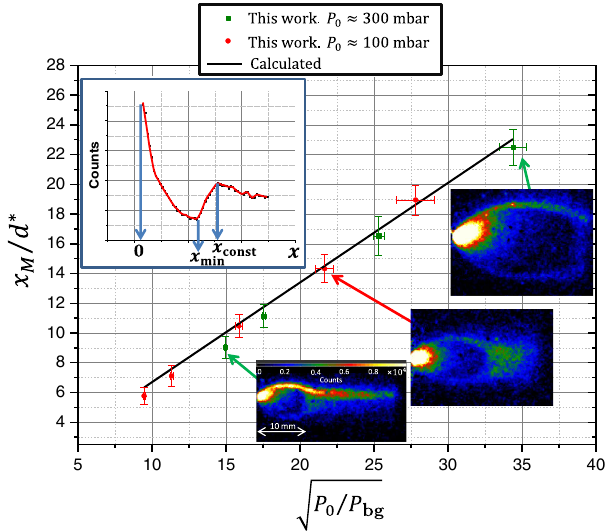
FIG. 7. Distance x M of the Mach disk from the nozzle exit at p ffiffiffiffiffiffiffiffiffiffiffiffiffiffiffi P =P . d (cid:2) ¼ 1 mm. The green and red different values 0 bg symbols correspond to P 0 ≈ 300 mbar and P 0 ≈ 100 mbar as measured with the PLIF spectroscopy, respectively. The black line shows the outcome after using Eq. (18) [59,68]. The color code of the images of supersonic free jets indicates the number of counts collected at a pixel due to the fluorescence signal (white color corresponds to the most intense fluorescence signal). The inset shows the observed fluorescence signal as a function of the distance from the exit hole recorded for the central jet line. The positions of x and x , used to determine x M as min const explained in the text, are indicated. deviation from the 1 =R 2 trend was observed even for x coordinates close to the nozzle exit. The background associated with the remaining scattered laser light and the dark current has been subtracted.